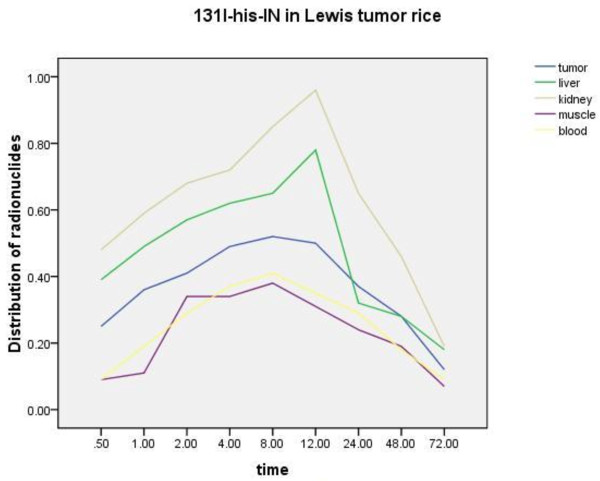
131I-His-IN distribution in different organs.